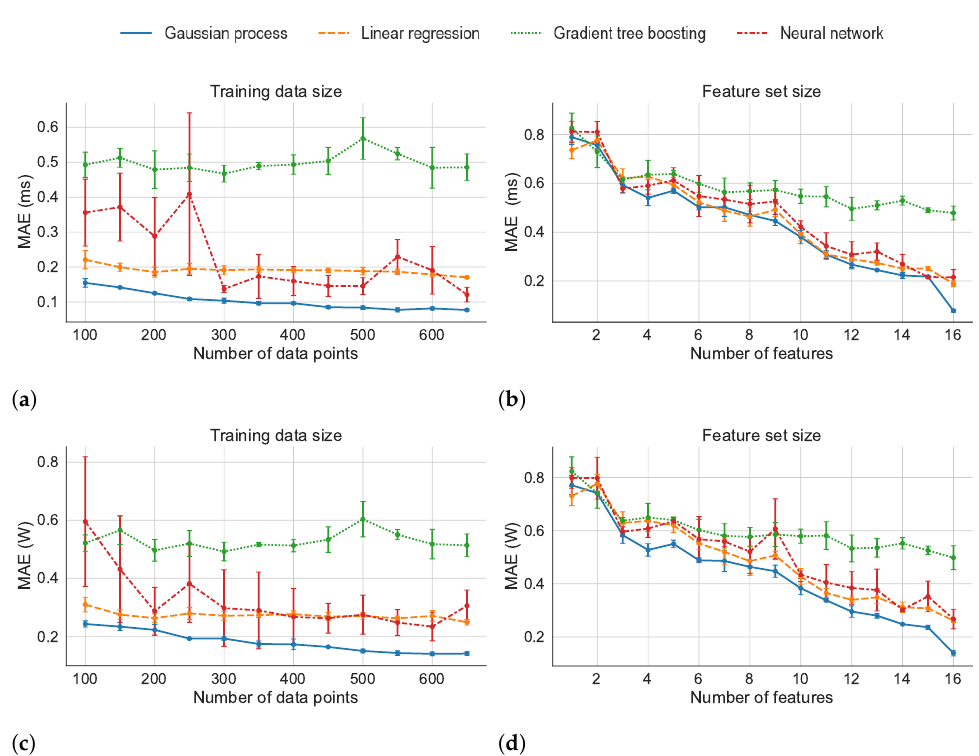
Figure 4. Prediction benchmarks for latency with respect to changing training data size ( a ) and feature set size ( b ). Benchmarks for energy with respect to changing training data size ( c ) and feature set size ( d